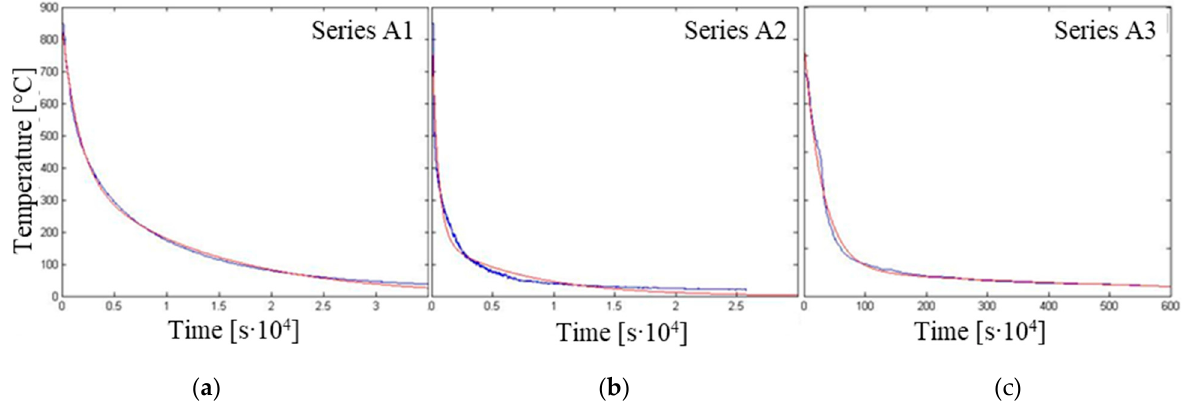
Figure A1. Measured (blue) and fitted (red) cooling profiles of thermal shock treatments ( a ) Series A1, ( b ) Series A2 and, ( c ) Series A3.